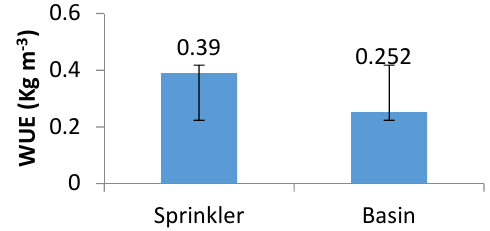
Fig. 4: WUE attained under T 1 and T 2